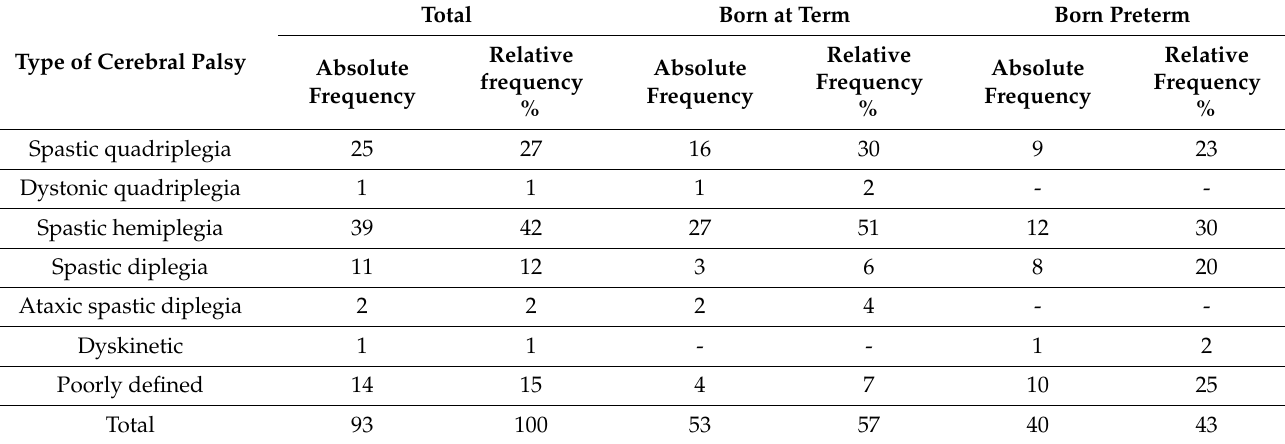
Table 1. Types of cerebral palsy (CP) in 93 affected children born at term and preterm.